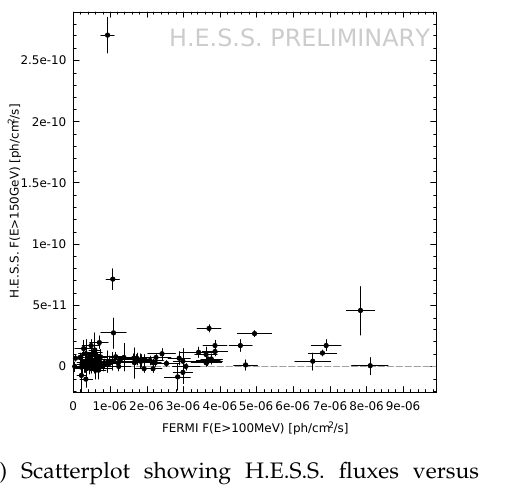
( a ) Scatterplot showing H.E.S.S. fluxes versus Fermi -LAT fluxes. The black dashed line marks the zero-flux level for the VHE band. Figure 3. Data points for simultaneous data from H.E.S.S. and Fermi